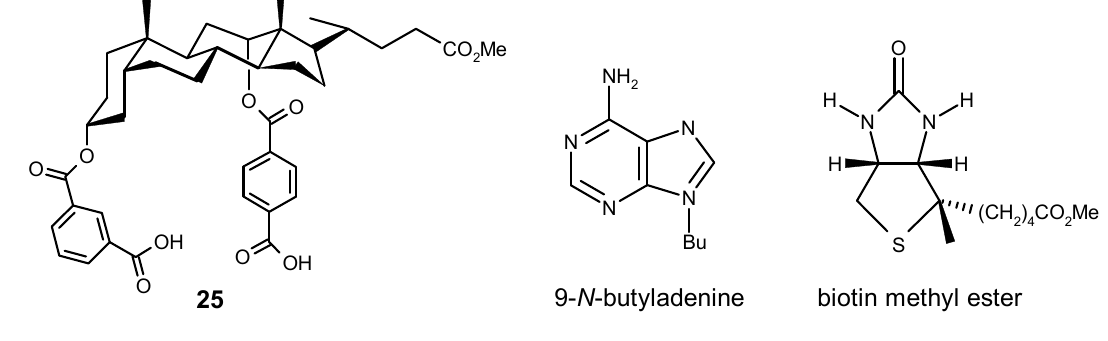
Figure 14. A new bile acid based adenine/biotin receptor 25 [103].